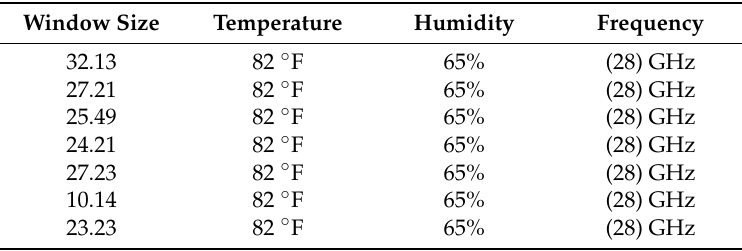
Table 3. Random measurements from the collected dataset.